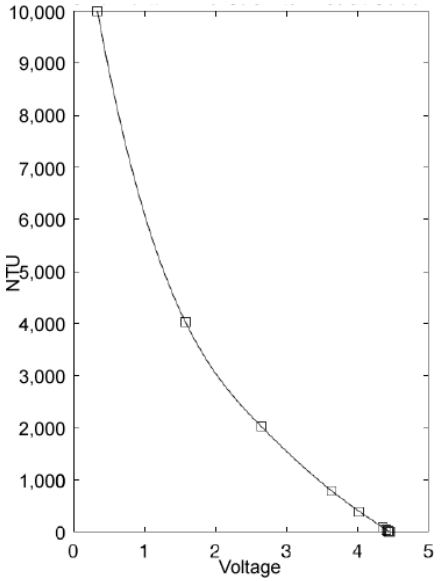
Figure 11. Voltage versus Nephelometric Turbidity Units (NTU): Least squares fit.